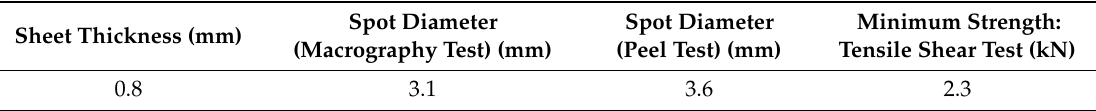
Table 4. Dimensions and minimum tensile strength used for welding spot